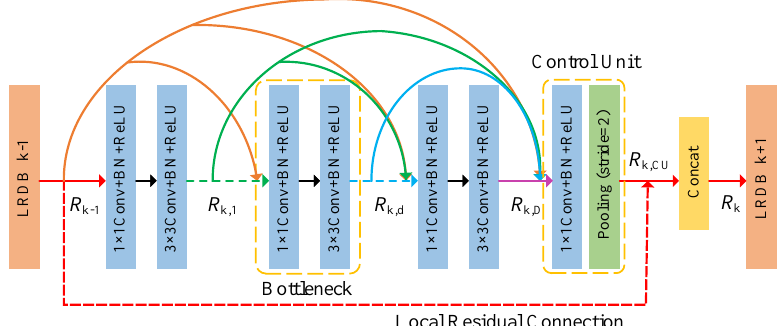
Figure 7. The architecture of the local residual dense block